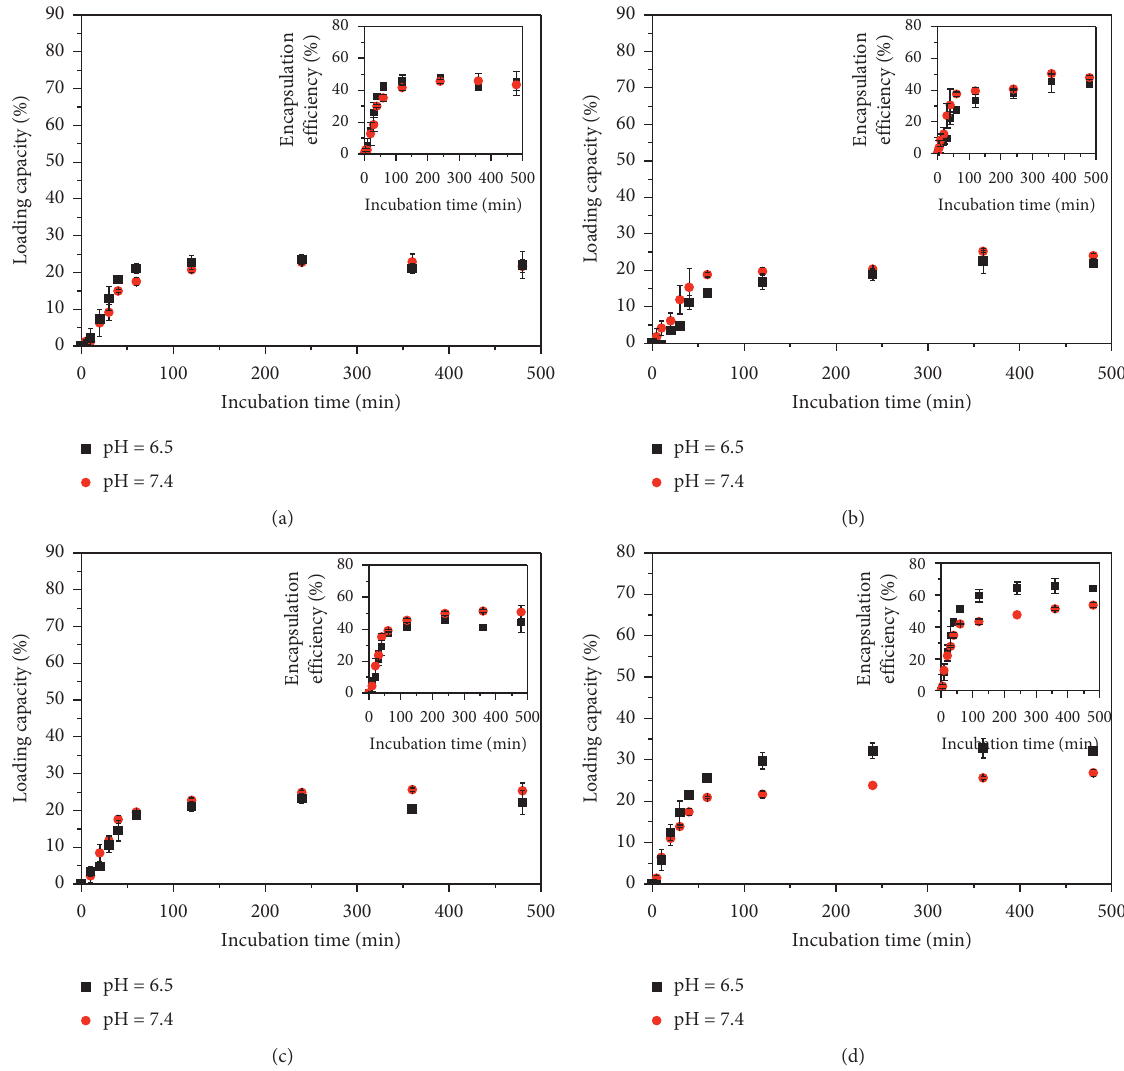
Figure 4: Drug-loading profiles of Doxy in nanocarriers at different pH and loading time: (a) TMPAC-MSNs, (b) TMPAC-MSNs-NH (c) TMPAC-MSNs-SH, and (d) TMPAC-MSNs-SO −